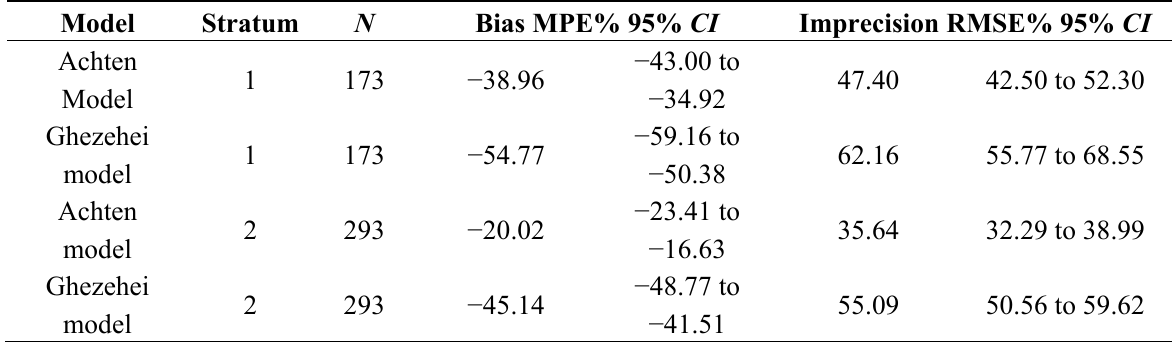
Table 6. Predictive performance of the allometric model in the validation dataset.